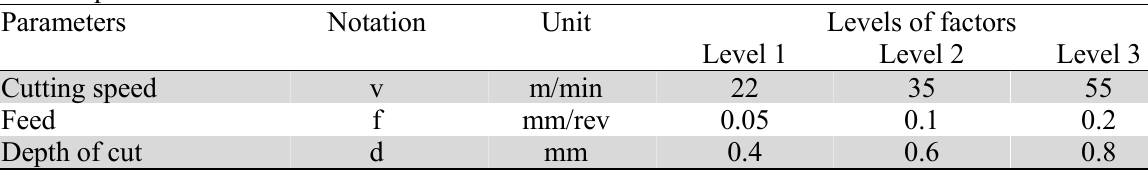
Experimental layout using Taguchi L Cutting